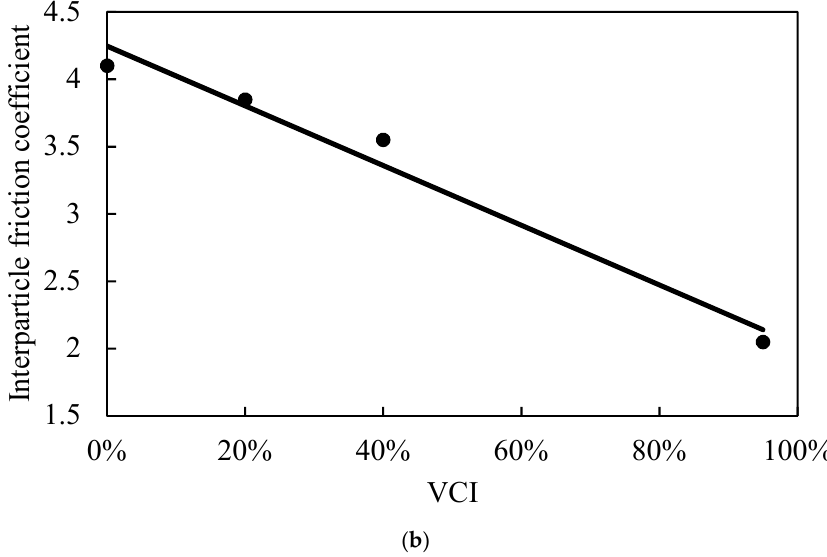
Figure 10. Changes in the micro-properties of the fouled ballast with the increase in VCI ratio: ( a ) change in effective modulus; ( b ) change in inter-particle friction coefficient.